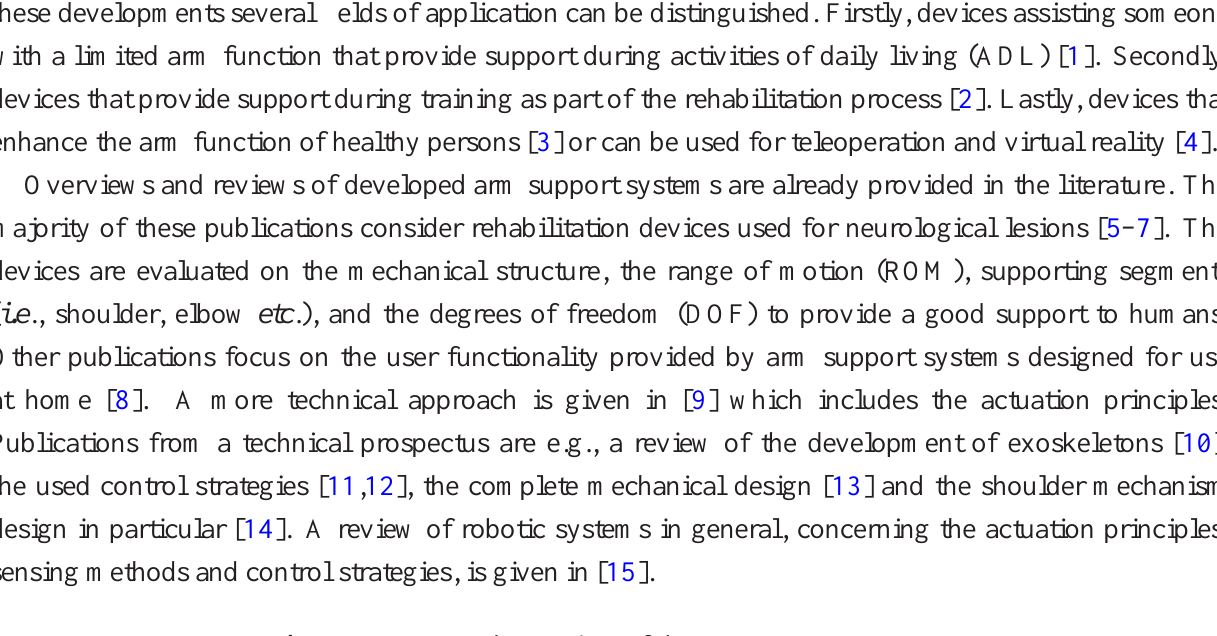
Figure 1. Proposed overview of the arm support